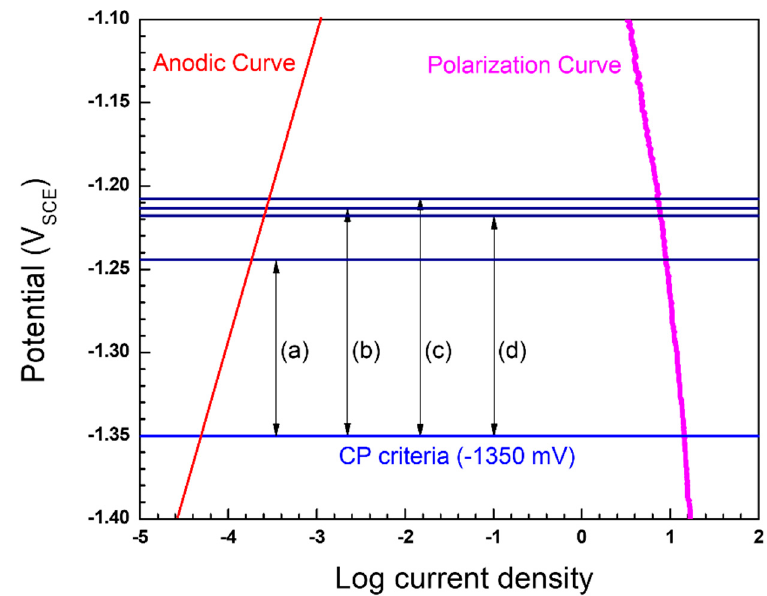
Figure 6. Calculation of additional current caused by IR drop in the polarization curve: potential difference of ( a ) 1%, ( b ) 5%, ( c ) 10%, ( d ) 20% defected pipelines. Table 7. Results of calculated additional CP current and optimized current for CP.